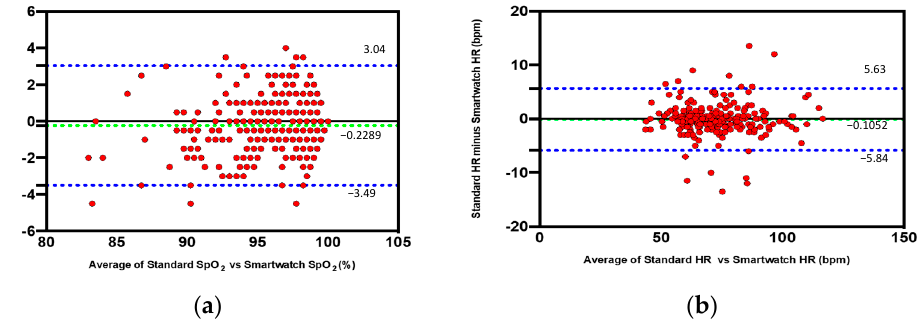
Figure 2. Concordance between SpO2 and HR measured by the smartwatch in comparison with the standard commercial device using Bland–Altman analysis. Bland–Altman plots indicate the level of agreement between the smartwatch and the standard commercial device. The dashed green line represents the bias (mean difference), and the dashed blue lines represents the upper and the lower limits of agreement. This difference is considered clinically nonsignificant. ( a ) Difference in % of SpO2 between the smartwatch and the standard commercial device plotted against the mean of the two readings. ( b ) Difference in beats per minute in HR between the smartwatch and the standard commercial device plotted against the mean of the two readings.